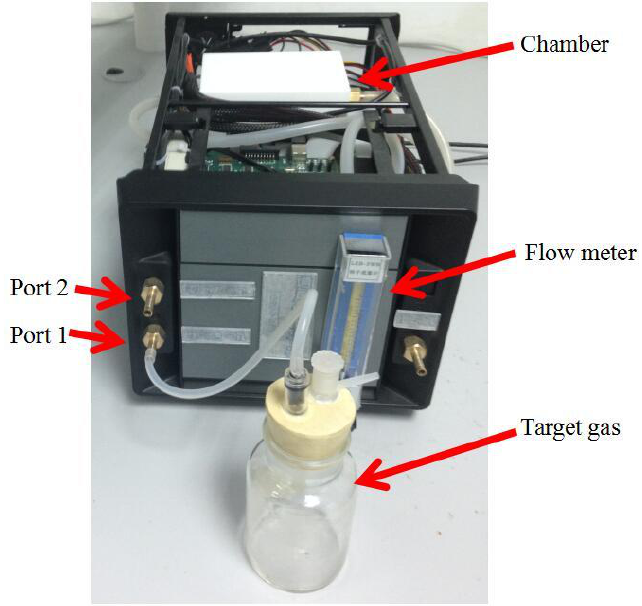
Figure 2. Image of the experimental setup.